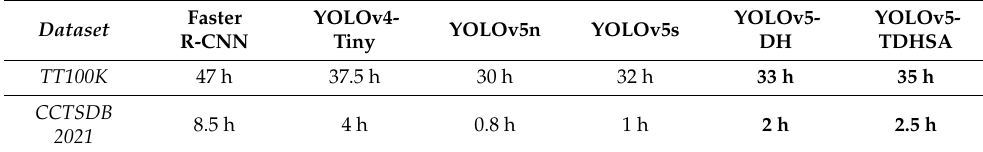
Table 4. Single experiment duration of compared models.